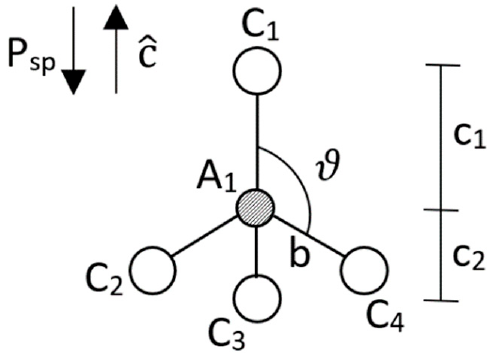
Figure 2. Wurtzite elementary unit cell where atoms are labeled as anions, A, and cations, C, and the parameters b and ϑ being the bond length between the A 1 atom and any of the southern cations (C 2 –C 4 ) and the bond angle between the C 1 atom and any of the southern cations (C 2 –C 4 ), respectively. Using Equation (4) and known lattice parameters of various binary pure wurtzite struc- tures we can calculate their bulk P sp values and compare against that of both experimental and theoretical results, Table 1. Table 1. Experimentally obtained lattice parameters for various wurtzites along with Born effective charges and P sp values which were obtained both experimentally and theoretically. Wurtzite